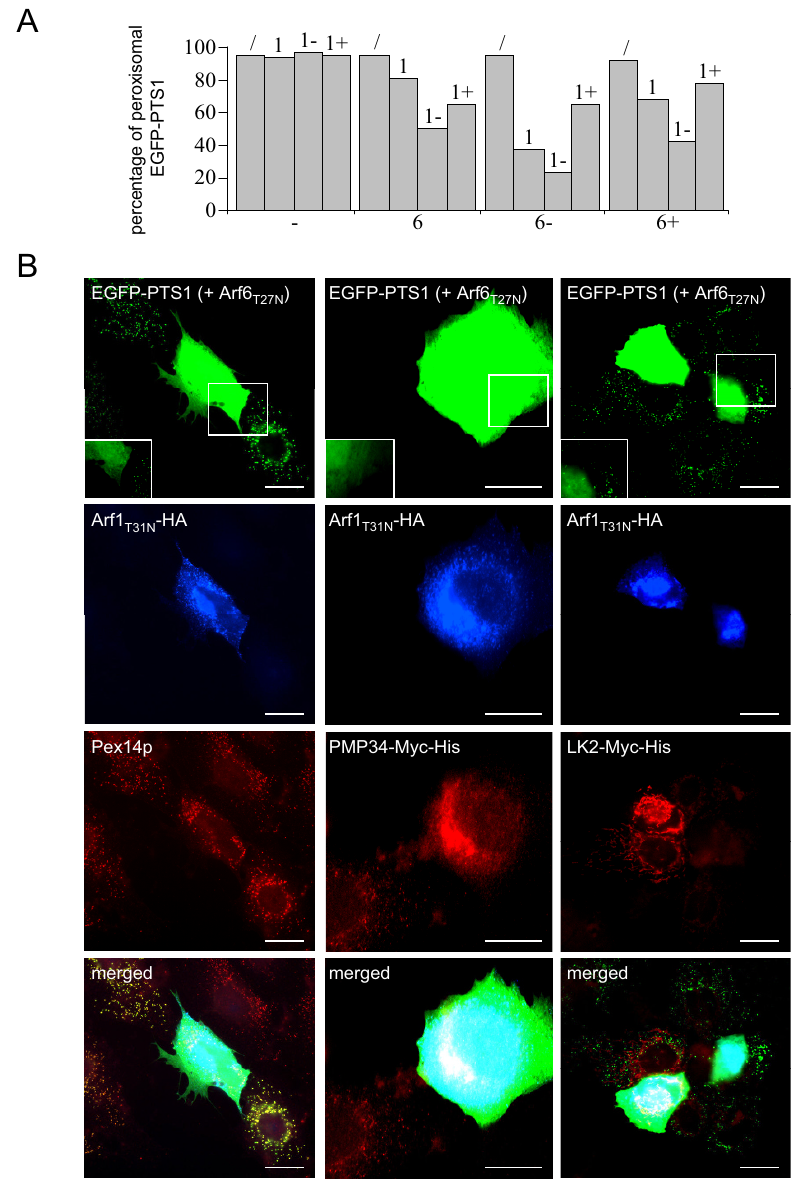
Figure 7 Effect of co-overexpression of Arf1 and Arf6 variants on peroxisomal and mitochondrial protein import in PtK2 cells . (A) Ptk2 cells were transiently transfected with plasmids coding for no protein (/), Arf1 -HA (1), Arf1 -HA WT T31N (1-), or Arf1 -HA (1+) and/or a bicistronic plasmid encoding EGFP-PTS1 together with no other protein (-), non-tagged Q71L Arf6 (6), Arf6 (6-), or Arf6 (6+). After 36 hours, the cells were fixed and processed for fluorescence analysis. The WT T27N Q67L subcellular localization of EGFP-PTS1 was determined by its punctate (peroxisomal) or diffuse staining pattern in at least 250 cells, and the results were quantified. (B) Representative images of the subcellular distribution pattern of EGFP-PTS1, HsPMP34-Myc-His, and HsLK2-Myc-His in Ptk2 cells co-overexpressing Arf1 and Arf6 . Note that the latter protein is T31N T27N encoded by the bicistronic expression vector coding for EGFP-PTS1, and a mislocalization of the reporter proteins is only observed in double-transfected cells. As (i) in mammalian cells the fluorescence intensity of EGFP-PTS1 is significantly higher upon mislocalization to the cytosol [77], and (ii) this increase may mask the (partial) association of this reporter protein with peroxisomes, insets are included in which the outlined regions are shown with moderately less intense green fluorescence sig- nals. Scale bar: 20 μ